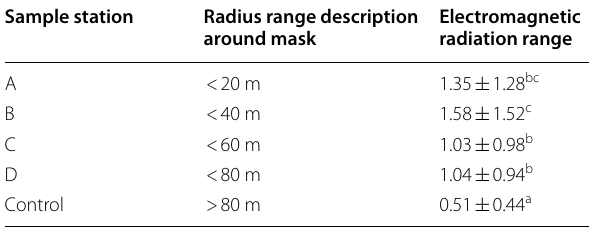
Table 1 Sampling stations radii ranges around the telecommunication mast and their respective EMR characteristics Sample station